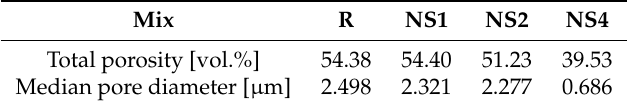
Table 5. Results of the mercury intrusion porosimetry (MIP) measurements.